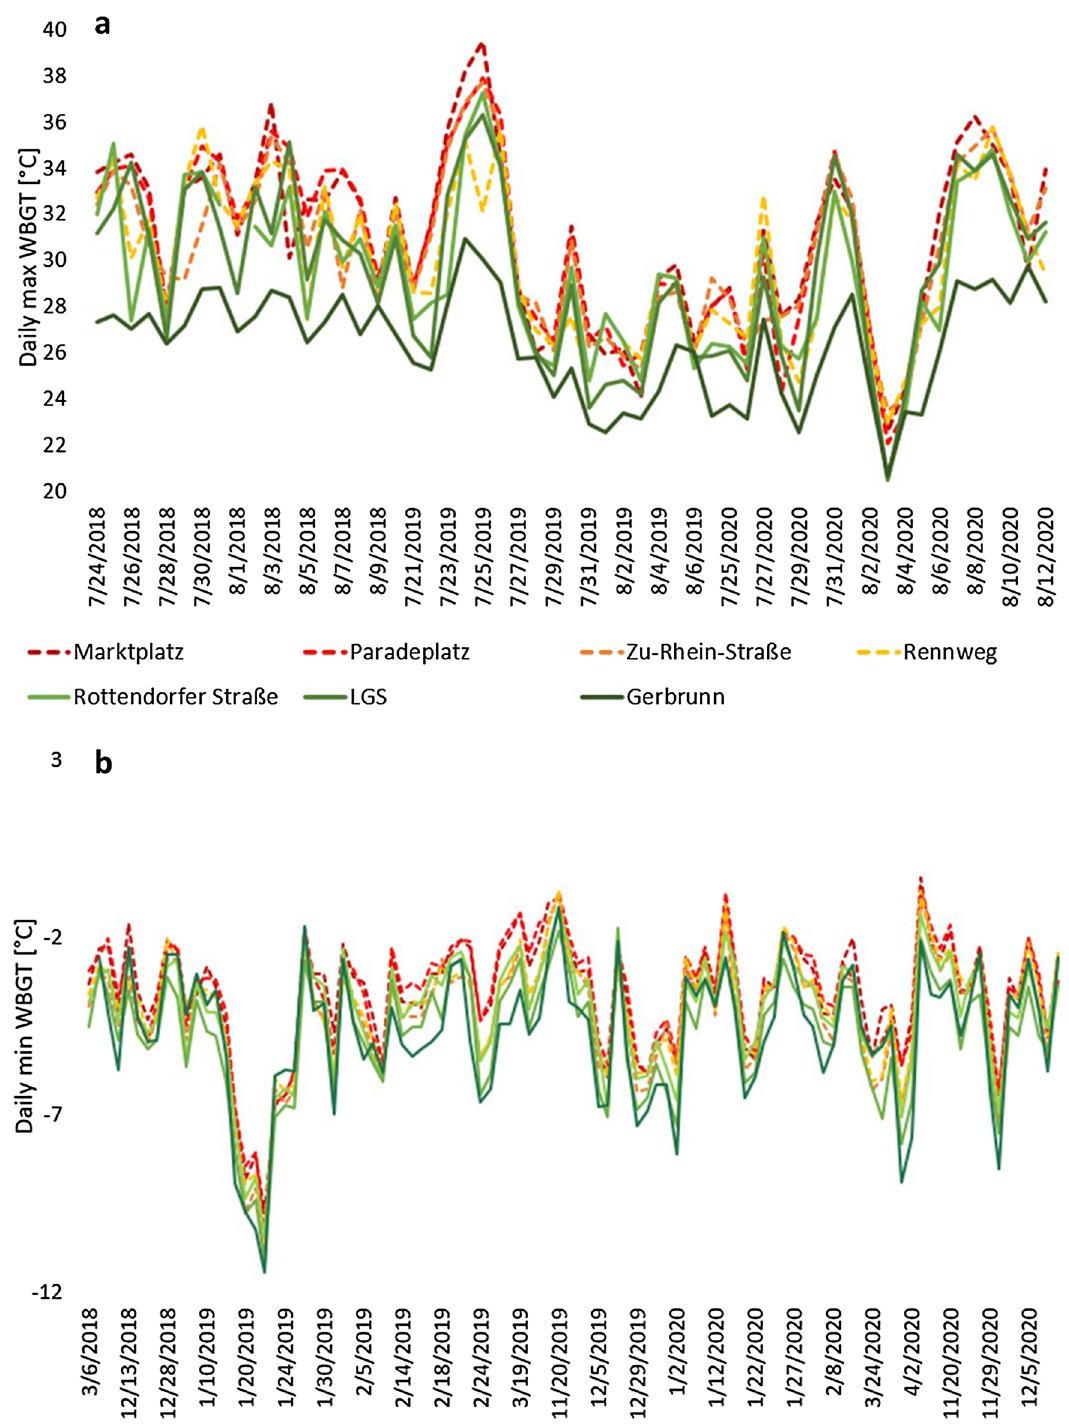
Figure 5. Daily maximum WBGT at seven sites in Würzburg during the hottest weeks over 3 investigated years (2018–2020) ( a ) and minimum WBGT during the cold days (minimum air temperature < 0 °C) ( b with high-rise buildings affect the aerodynamics and microscale wind conditions 34 . Hence, the cooling range of greenspaces is not only dependent on the size and shape of greenspaces 55 but also on the morphology of the built up area surrounding the greenspaces 56 . Therefore, during the summer days, the building heights and the proportion of land cover can significantly increase the WBGT. On the other hand, during cold days, sub-urban sites were significantly colder compared to the urban sites. There were no significant differences regarding WBGT within the urban sites. Nevertheless, the succession of more built-up areas and buildings and less green areas showed effects on the extent of outdoor thermal stress.